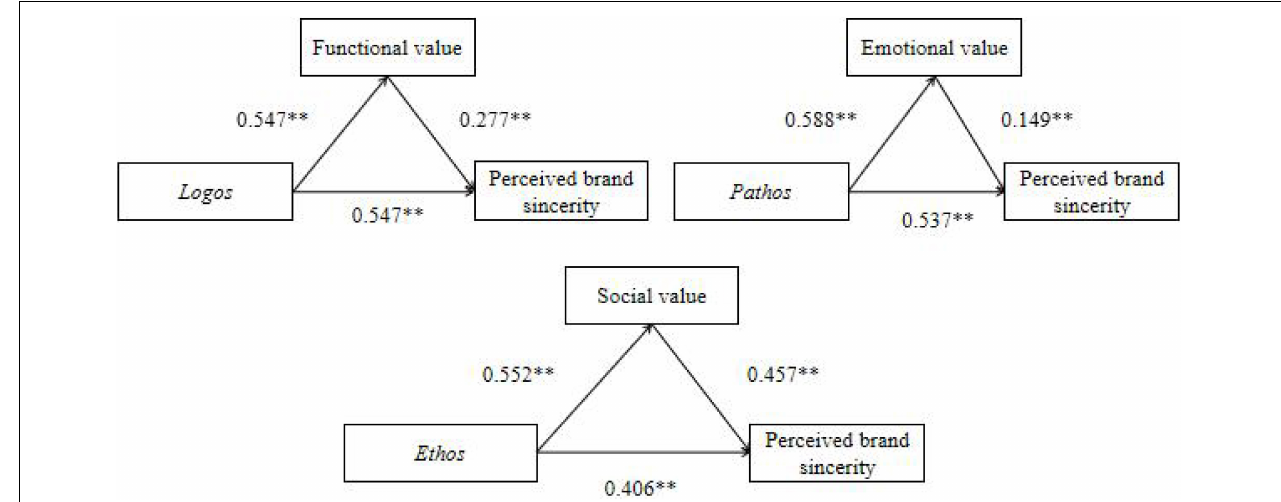
FIGURE 3 | Mediation analysis. ∗∗ p < 0.01.